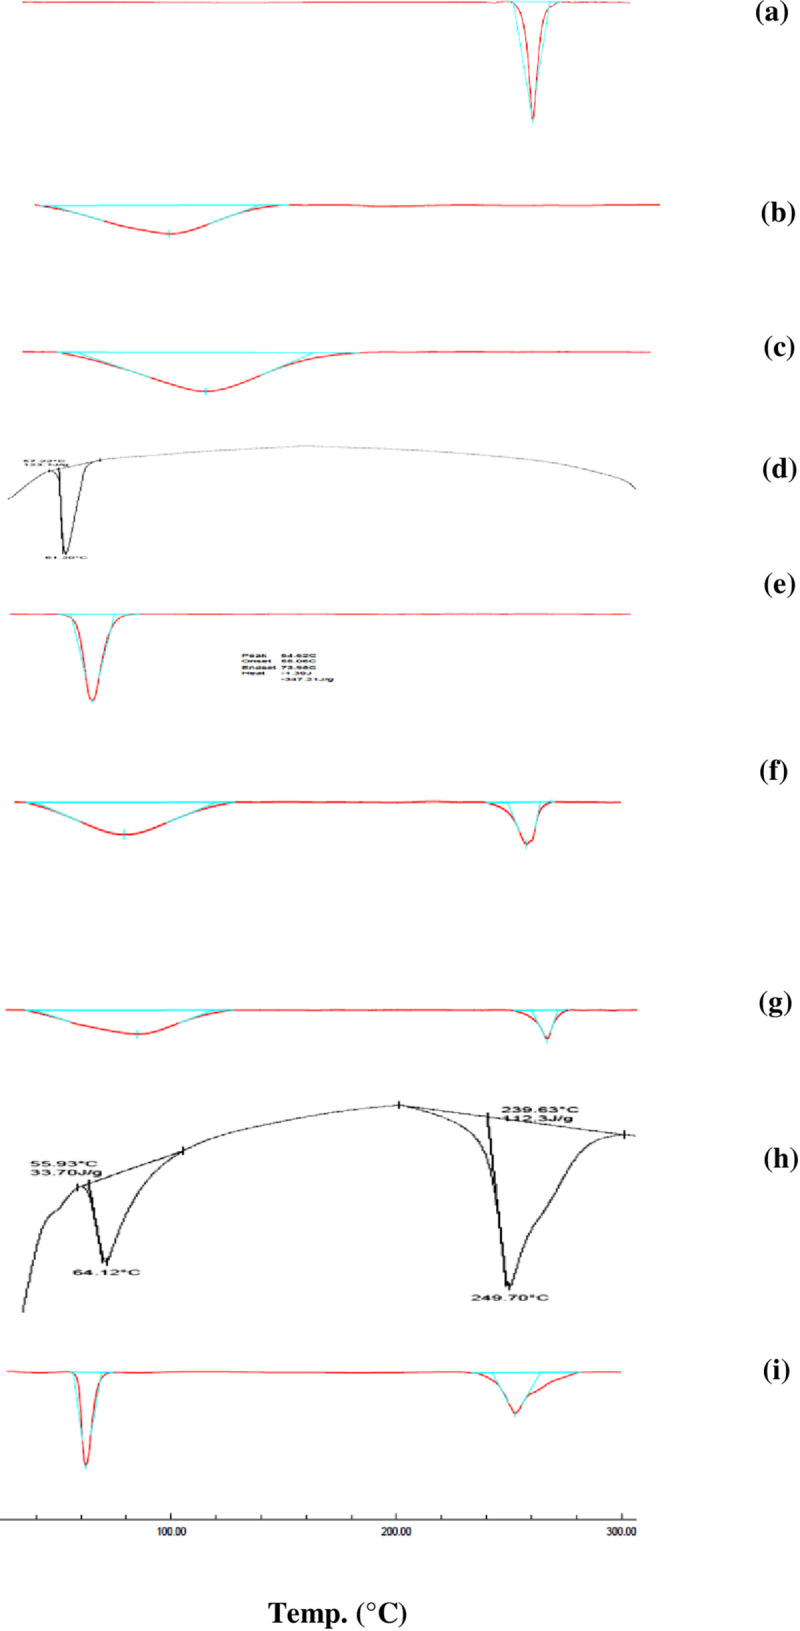
DSC compatability studies of plain drug (a), PVP K25 (b), PVP K90 (c), PEG 4000 (d), PEG 8000 (e), PM of drug and PVP K25 (f), PM of drug and PVP K90 (g), PM of drug and PEG 4000 (h) and PM of drug and PEG 8000 (i).